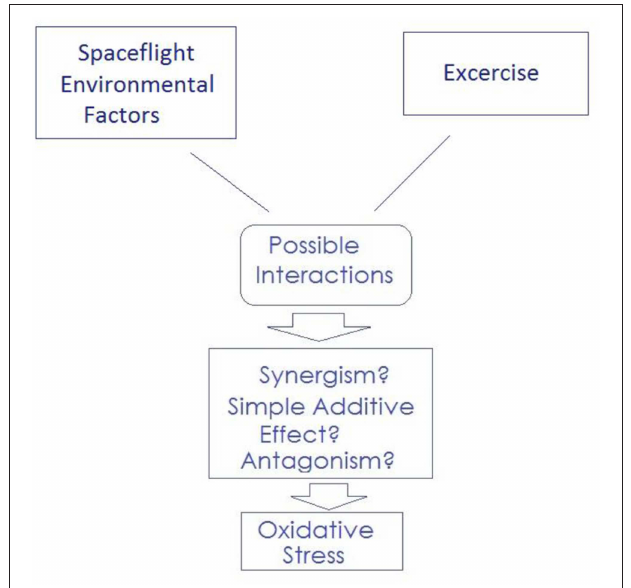
FIGURE 1 | Both physical exercise and Spaceflight Environmental Factors can trigger oxidative stress. This combination can significantly amplify the level of oxidative